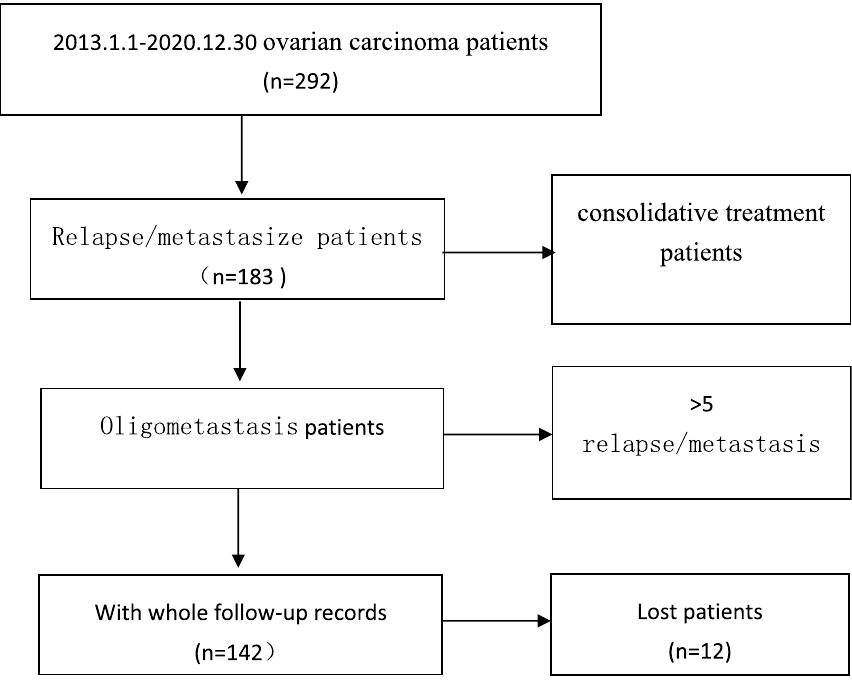
Fig. 1 Flowchart of patients